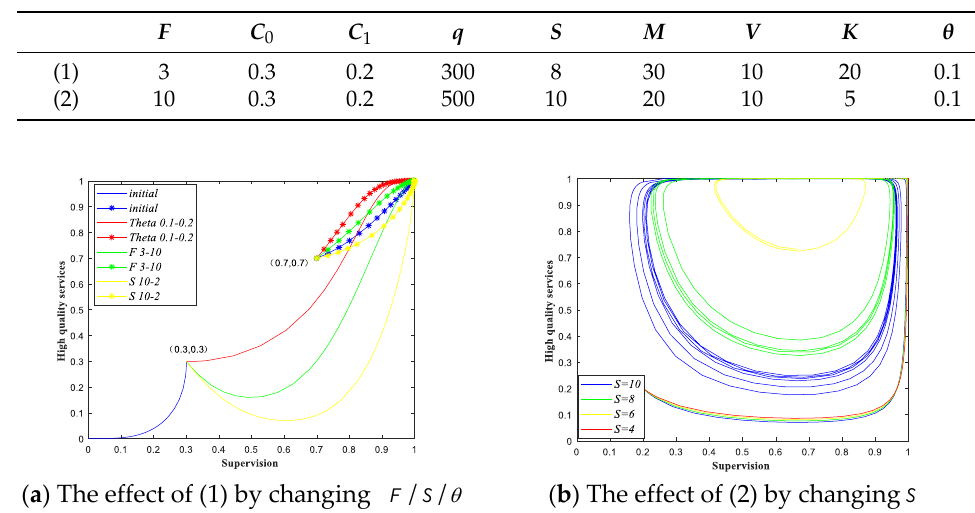
Table 5. Parameter settings for two initial situations.